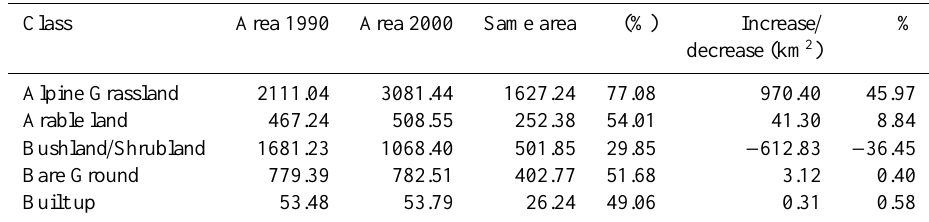
Table 4. Changes of selected classes within a 6390km 2 sized subset of the Lhasa river